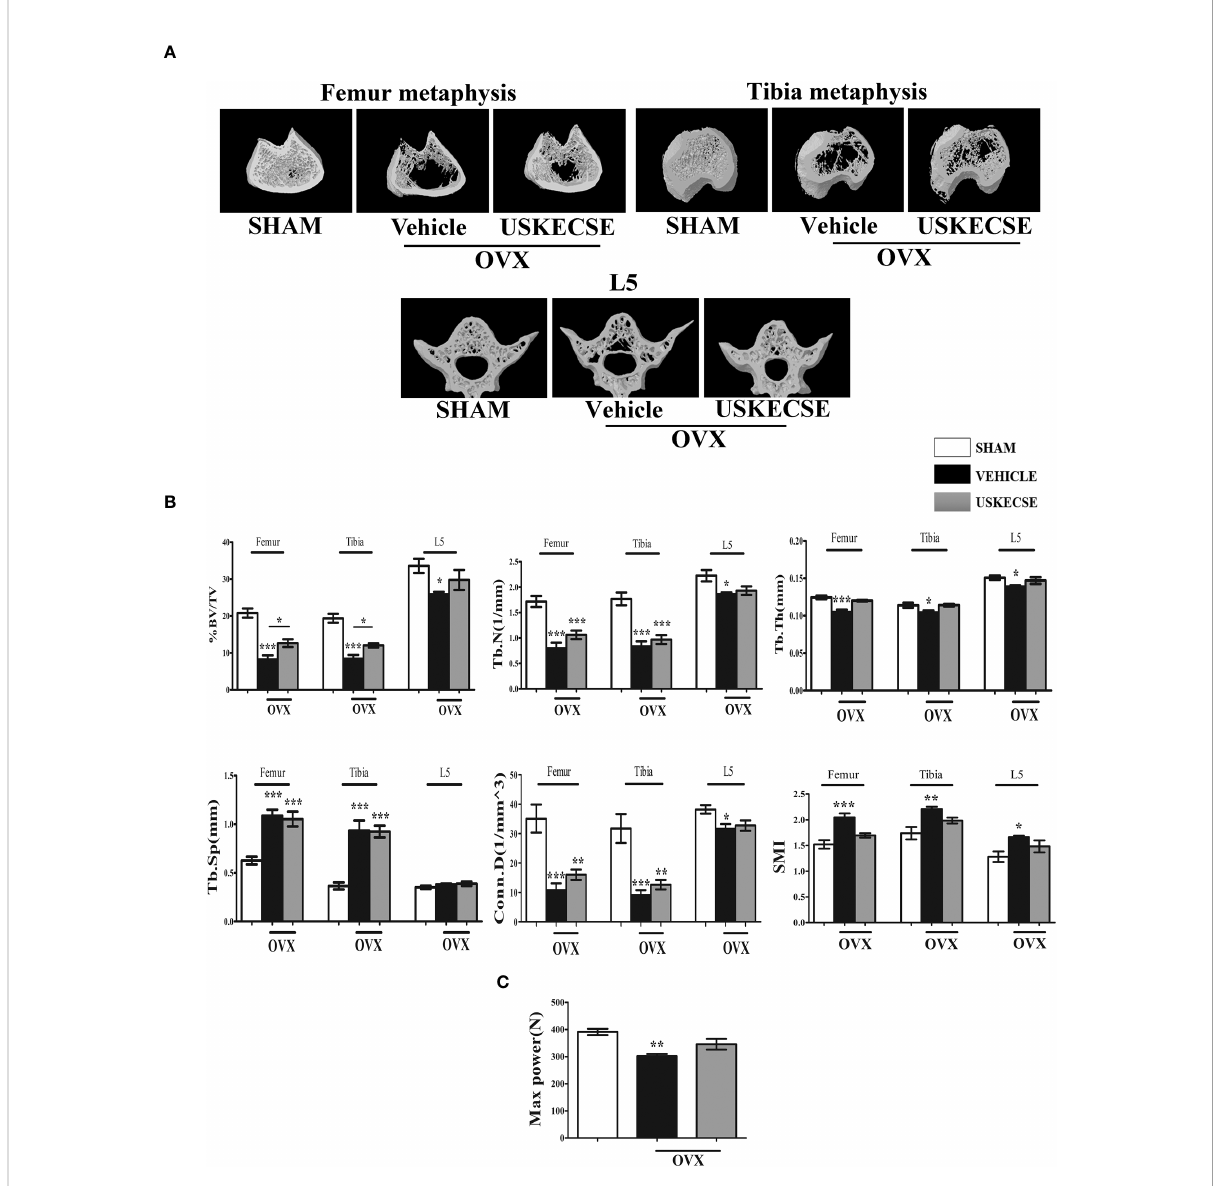
FIGURE 6 USKECSE prevented bone loss in osteopenic rats. (A) Representative images of femur metaphysis, tibia metaphysis, and L5 vertebrae are shown. (B) Shown are the quantitative µCT parameters of the femur, tibia metaphysis, and L5. %BV/TV, percent bone volume per tissue volume; Tb.N, trabecular number; Tb.Th, trabecular thickness; Tb.Sp, trabecular spacing; Conn.D., connectivity density; and SMI, structure model index. (C) The L5 compression strength was determined by a bone strength tester. Values are expressed as mean ± SEM ( n = 6 bones/group); * p <.05, ** p <.01, and *** p <.001 vs.